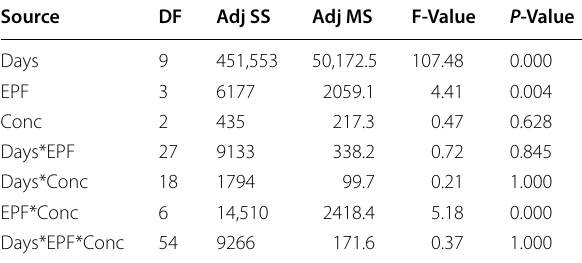
Table 4 F-values for three-way analysis of variance result on the differential effect of entomopathogenic fungi Galleria mellonella